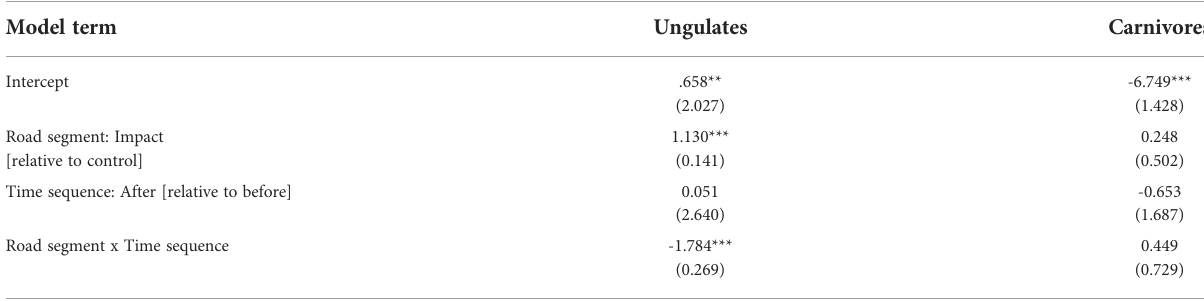
TABLE 3 Summary of the mixed-effect Poisson models to test for the interaction between road segment (control vs. impact) and time sequence (before vs. after) for all ungulate species pooled together and for all carnivores. Taxa